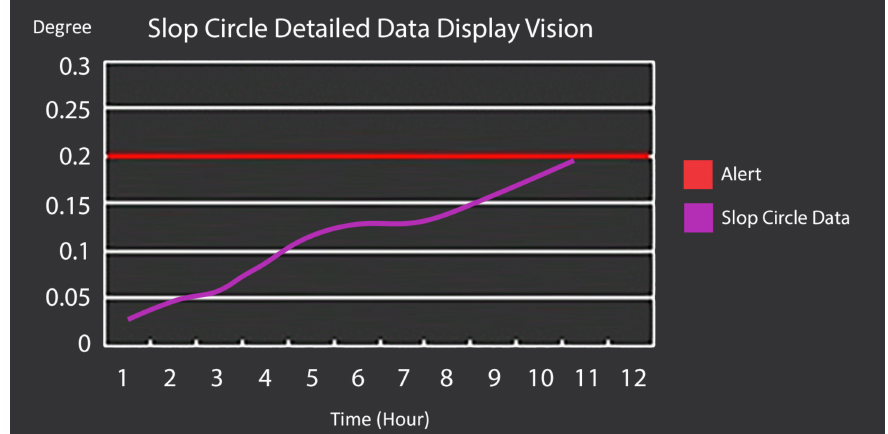
Figure 8. A detailed data display of the GPS.